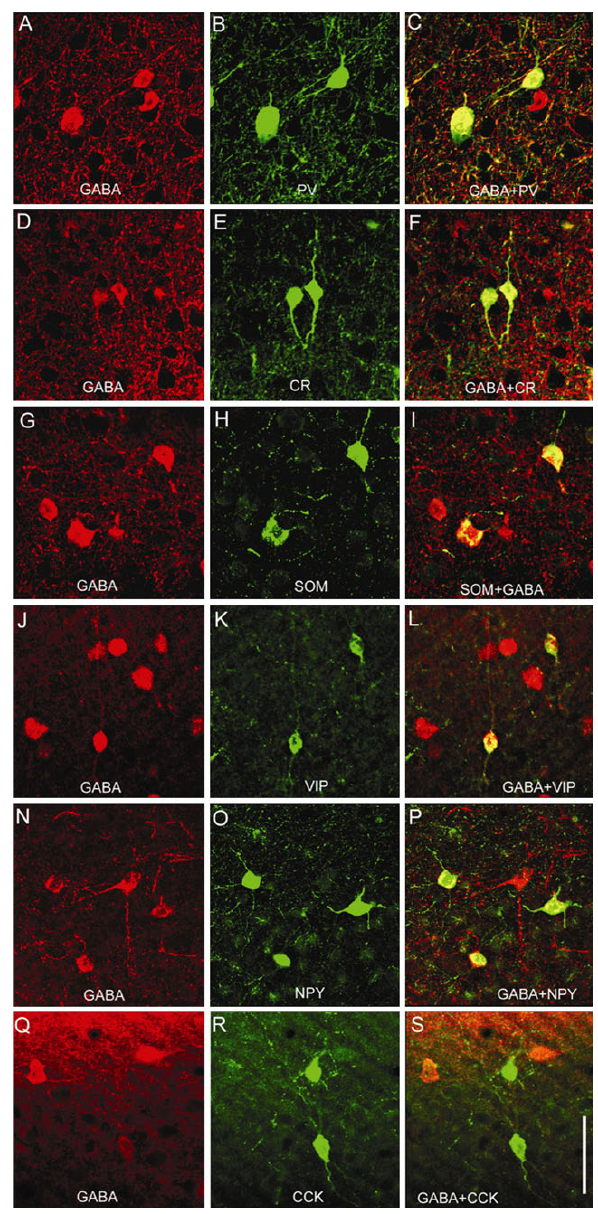
Figure 1. Expression of calcium binding proteins and neuromodulatory peptides in GABAergic neurons of adult mouse primary visual